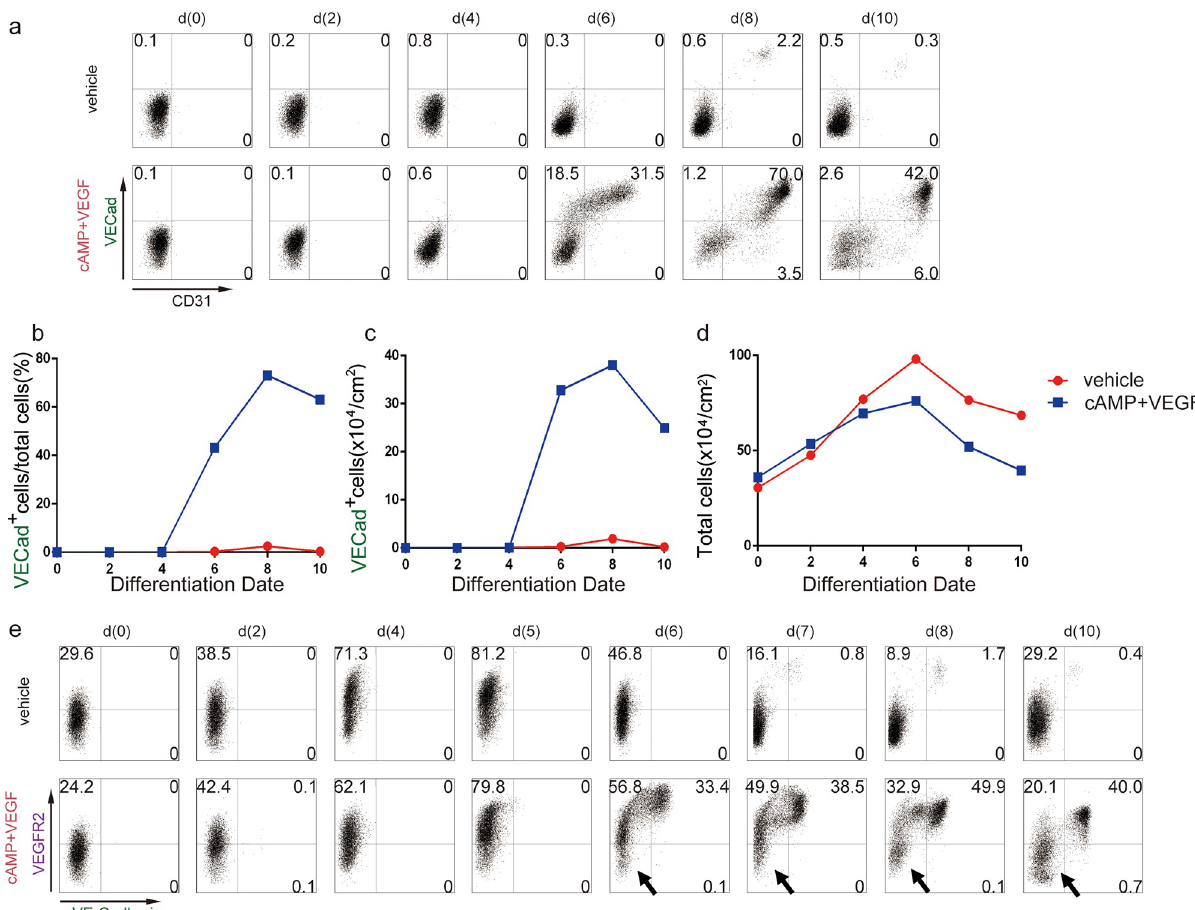
Fig 2. Time course of endothelial cell and pre-endothelial cell marker. (a) Representative expression time course of VE-cadherin (VECad) and CD31 under stimulationmethod (VEGF+cAMP) or vehicle without VEGF and cAMP by FACS. (b) Time course of VE-Cadherin-positivecell ratio in two groups. (c) Yield of VE-Cadherin positive endothelialcells per 1cm 2 in two groups. (d) Time course of total cell counts in two groups. (e) Representative expressiontime course of VEGF receptor 2 (VEGFR2) and VE-cadherin in stimulation method (VEGF+cAMP) or vehiclewithout cAMP and VEGF. Arrows: non-responder cells to VEGF and cAMP stimulation.